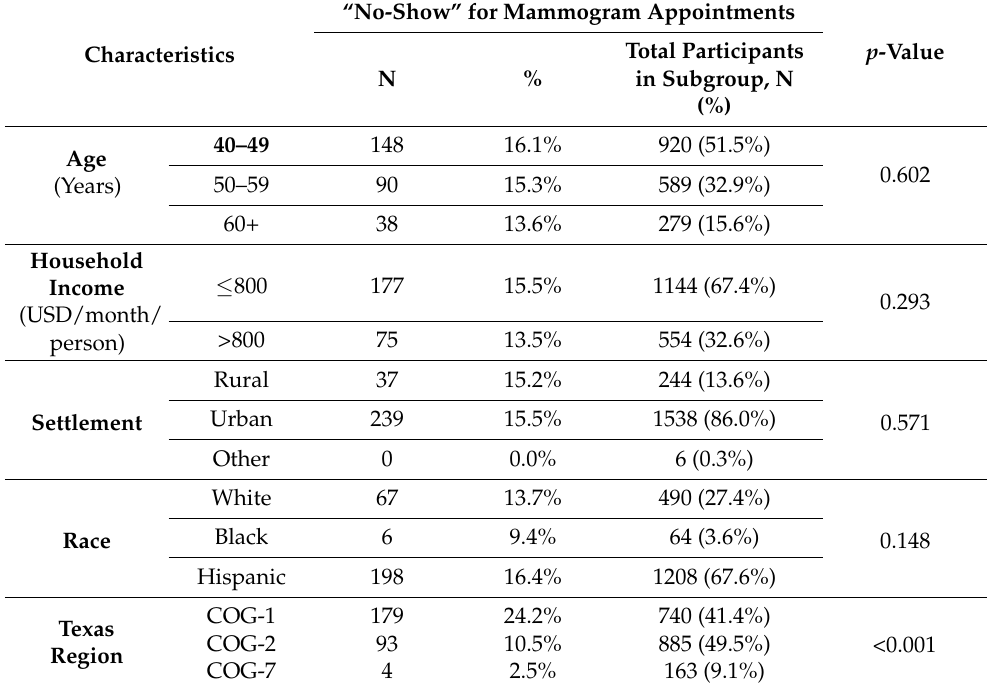
Table 2. Factors associated with the “No-Show” rate for mammogram screening appointments.